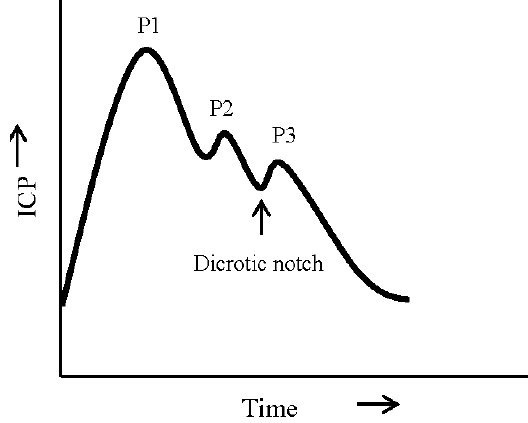
Figure 2. A single ICP pulse showing the components of ICP waveform. P1, percussion wave; P2, tidal wave; P3, dicrotic wave; and the beginning of P3 which aligns with the position of dicrotic notch on the arterial pulse.